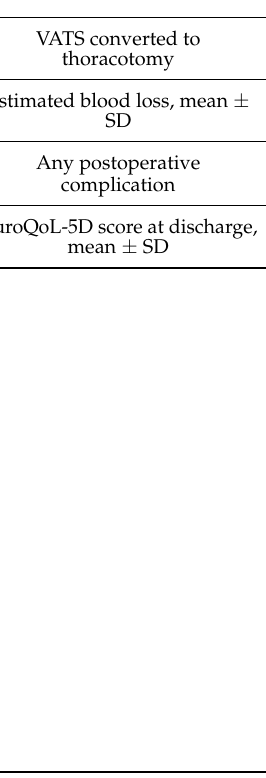
Table 3. Univariable and multivariable analysis for preoperative clinical risk factors of conversion. CI = confidence interval; COPD = chronic obstructive pulmonary disease; DLCO = diffusing capacity of the Lung for Carbon Monoxide; FEV1 = forced expiratory volume in 1 s; OR = odds ratio.